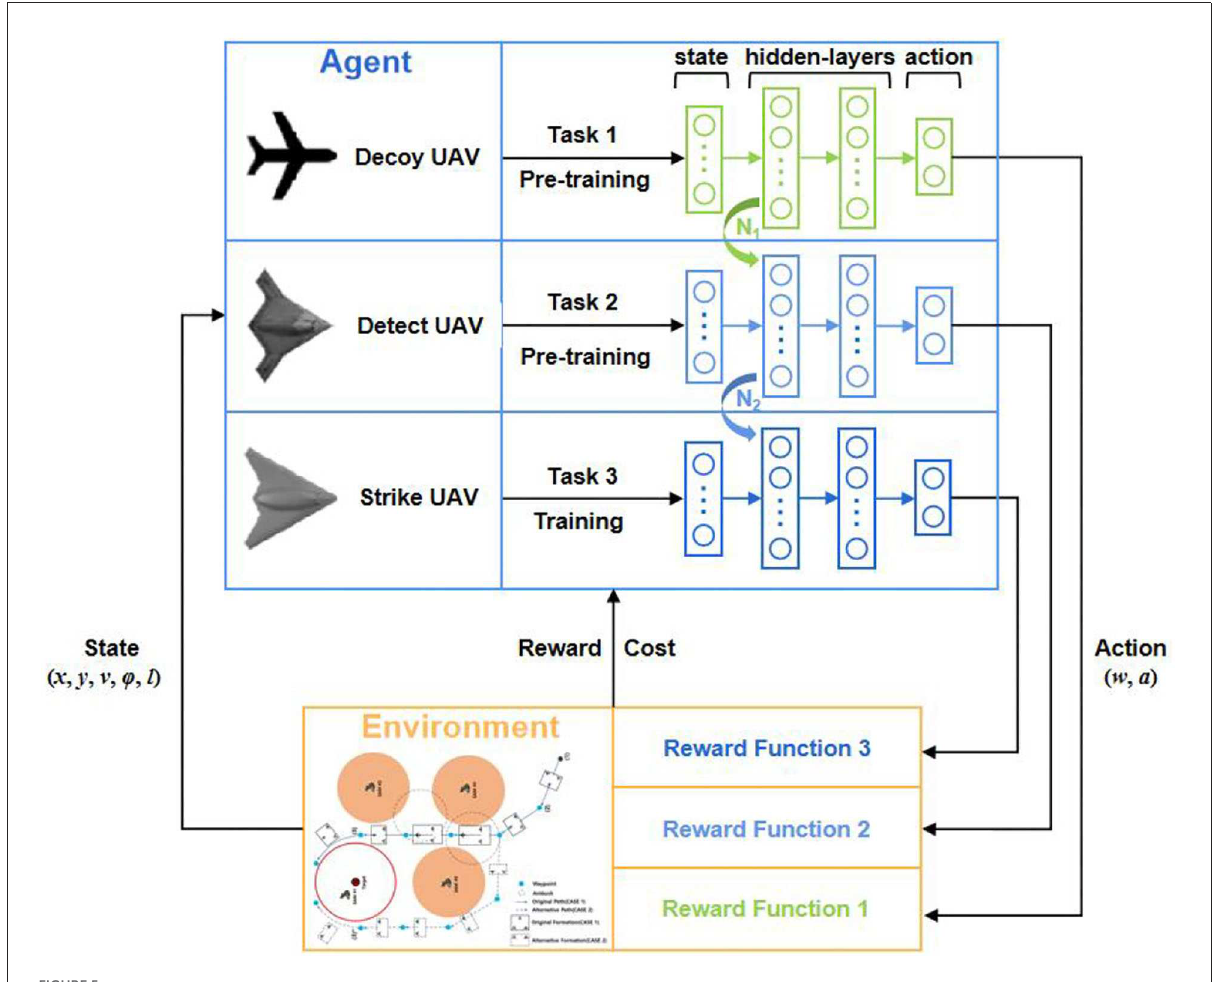
FIGURE5 Overview of our proposed